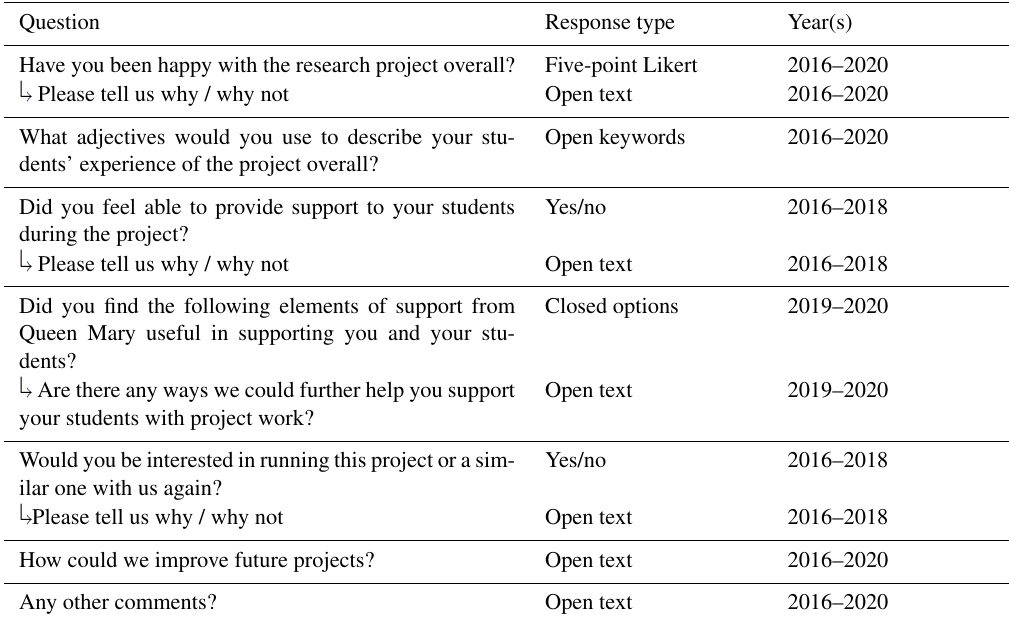
Table B2. The questions asked of